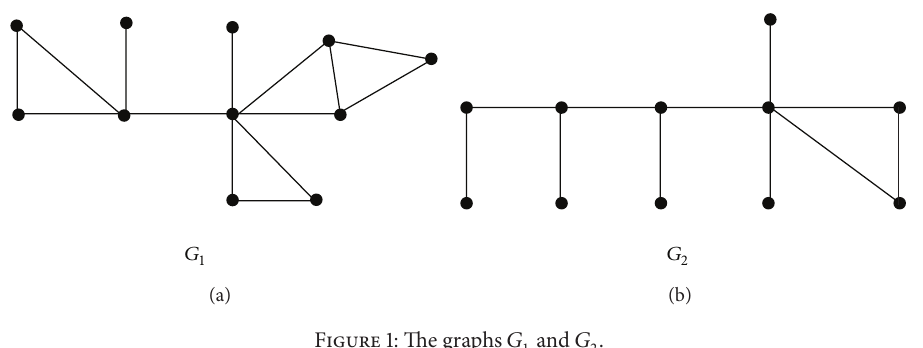
Figure 1: The graphs 𝐺 1 and 𝐺 2